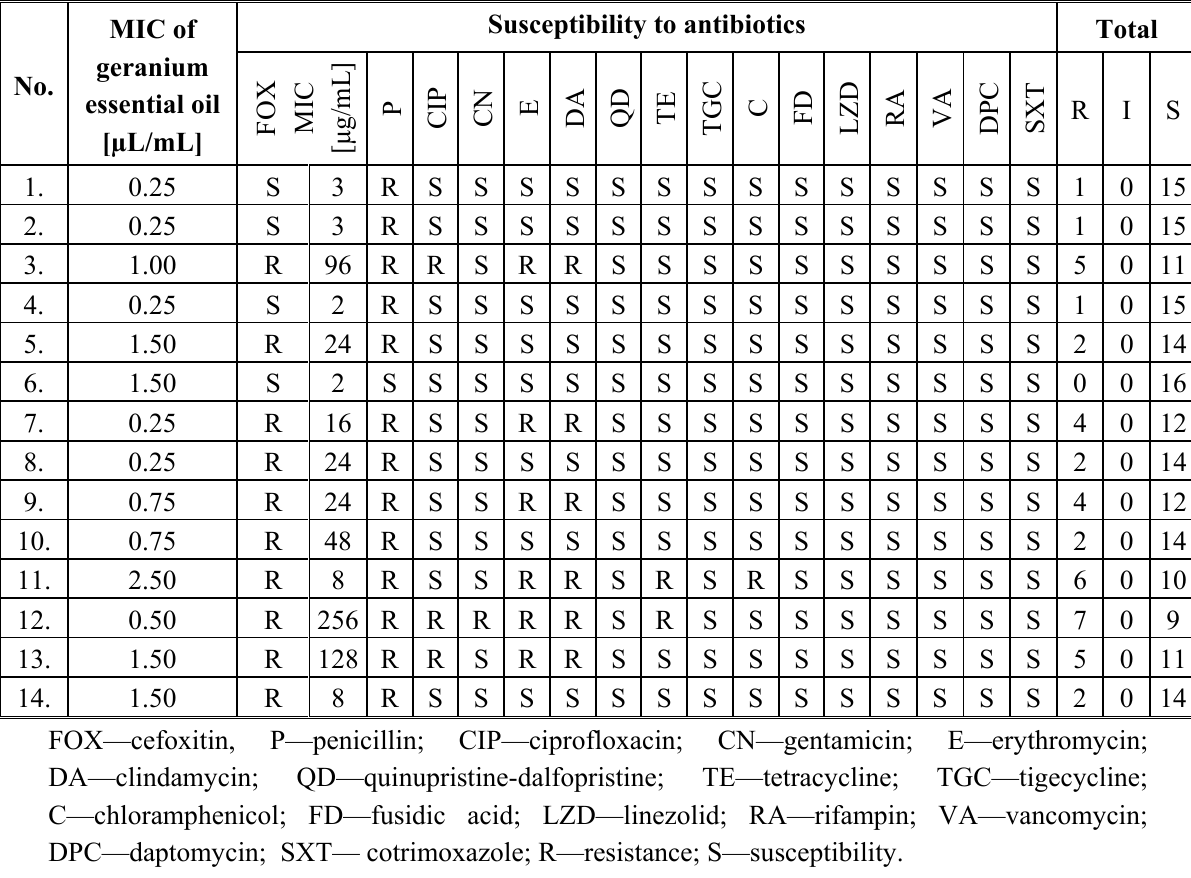
Table 5. Characteristics of S. aureus strains isolated from intubation tubes.